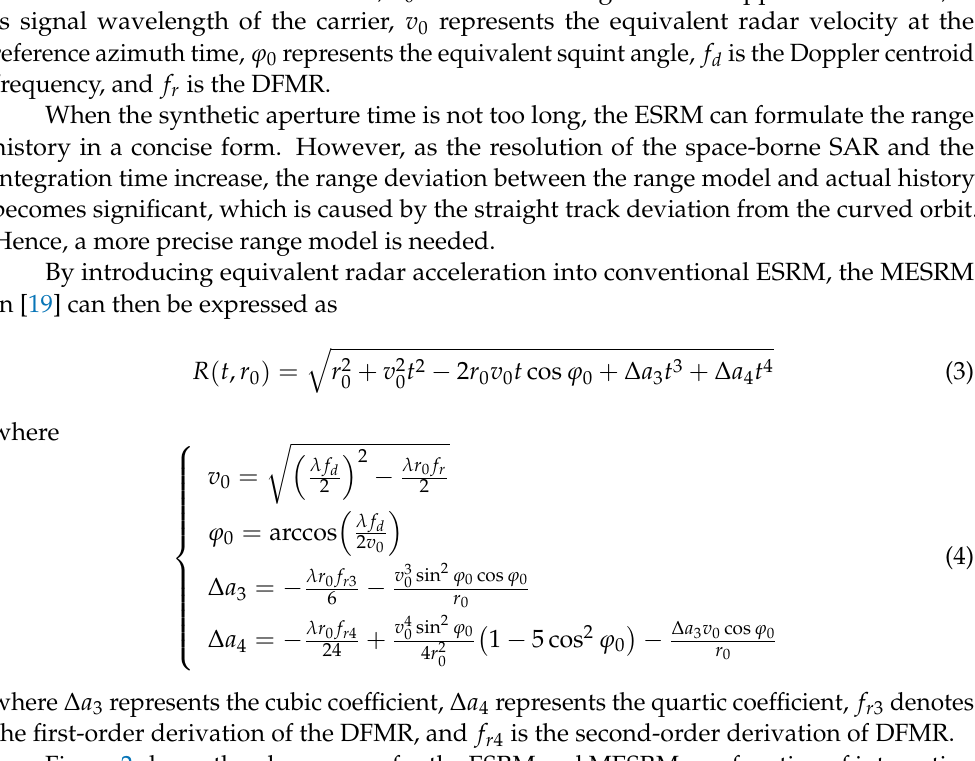
( c ) Figure 3. The slant range error and phase error as a function of azimuth time caused by MESRM. ( a – c ) represent the errors along azimuth direction in the near, central, and far range cells, respec- tively. Lines with different colors represent the errors of different targets with a constant interval of 2 km along azimuth direction. In conclusion, the MESRM can only match the range history for the central point target, but for the azimuth marginal point target, a non-negligible range deviation occurs, which will lead to the severe degradation of the imaging quality. It can be observed from Figure 3 that the quadratic term is the major component of the slant range error, and the magnitude of this error is approximately proportional to